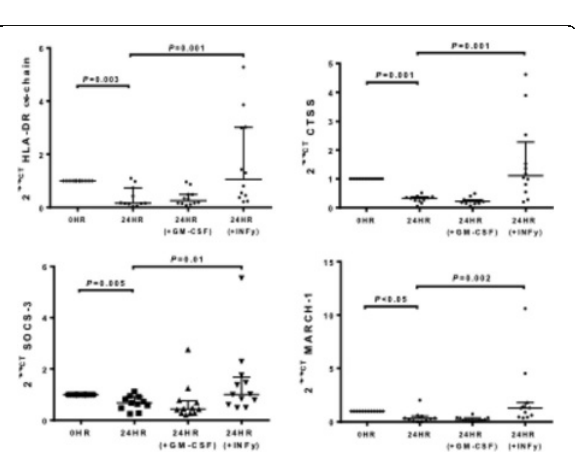
Fig. 20 (abstract A32). mRNA levels in monocytes incubated with post-operative serum containing either GM-CSF or INF γ . Dot plots, with median and IQR represented,